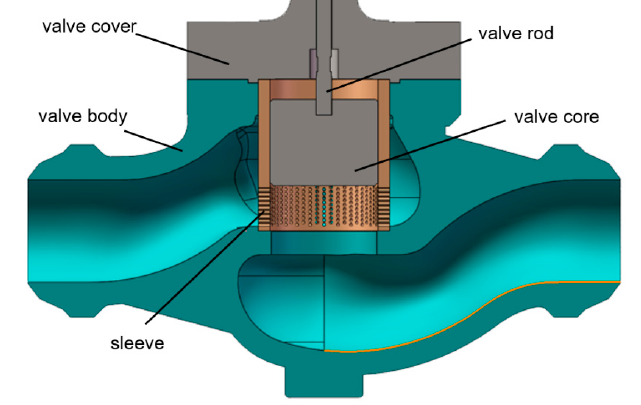
Figure 1. Schematic structure of the studied sleeve regulating valve.